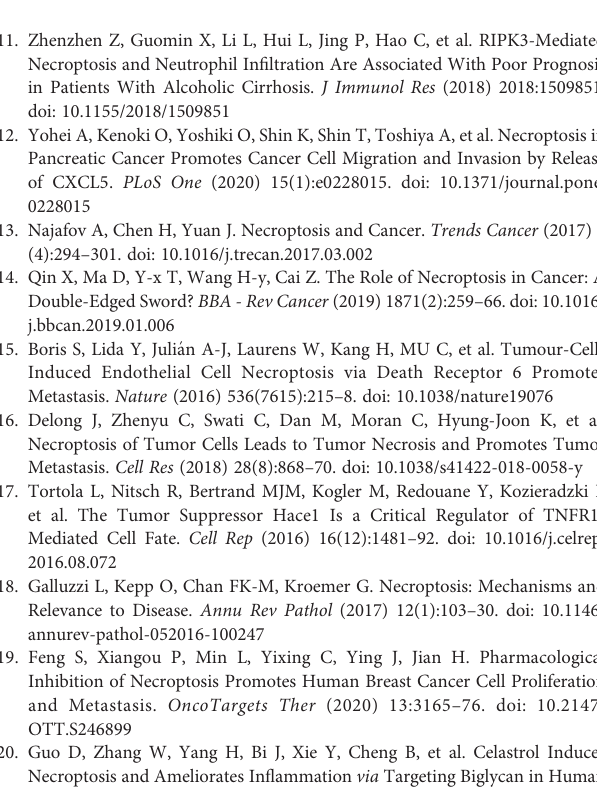
Supplementary Figure 11 | The structure of predicted targeted drugs based on the DEGs in different